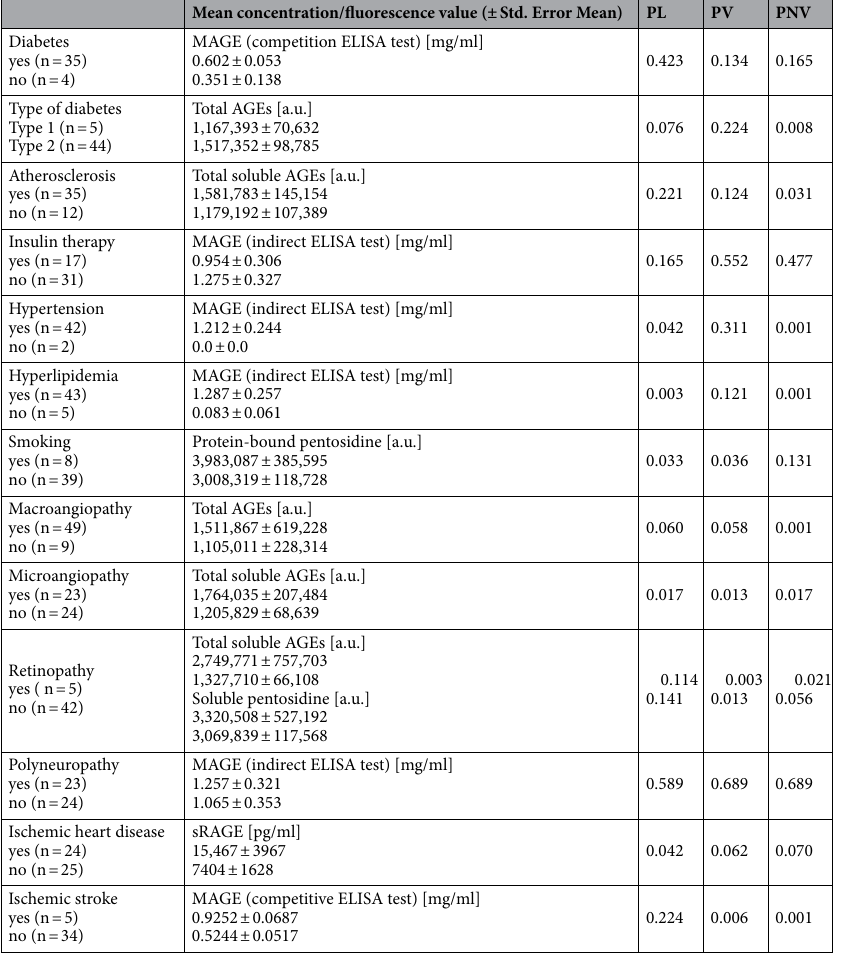
Table 1. The dependence of basic information about the health of patients on the concentration and fluorescence of AGEs and the concentration of AGE receptors. The statistically significant values are shown in red. PL—significance level for Levene’s test; PV – significance level for tke student’s t-test from the analysis of equality of variance; PNV – significance level for the students’s t-test of inequality of